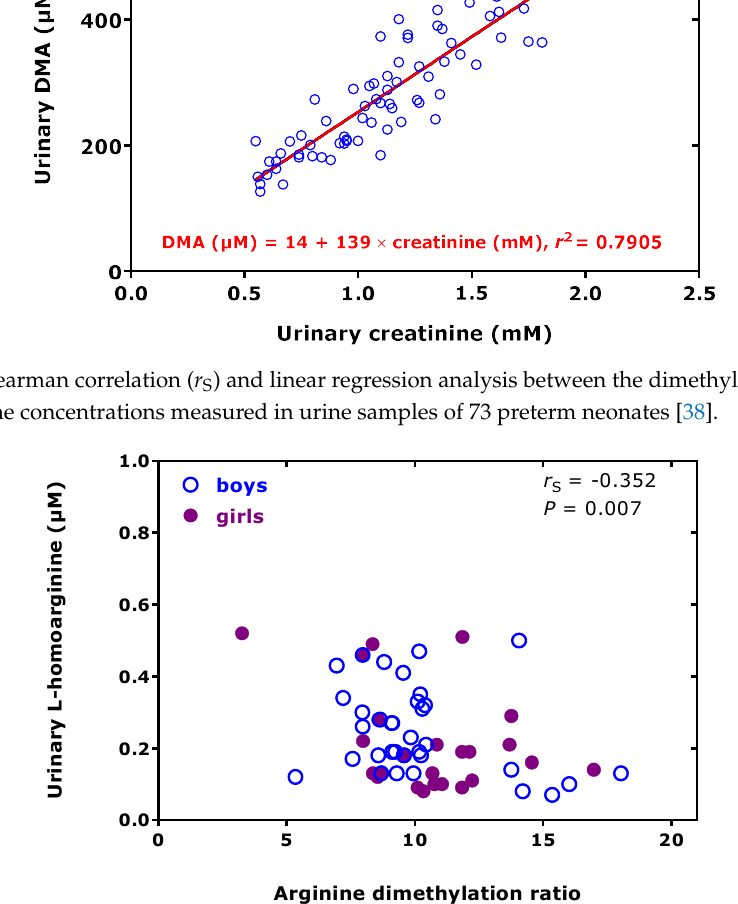
Figure 5. Spearman correlation ( r S ) between the urinary excretion of L-homoarginine and the arginine dimethylation ratio, the molar ratio of the sum of the urinary concentration of asymmetric dimethylarginine (ADMA) and dimethylamine (DMA) and of the urinary concentration of symmetric dimethylarginine (SDMA), i.e., (ADMA + DMA) / SDMA, in preterm neonates [38]. High correlations between DMA and creatinine concentrations in urine were also observed in black and white boys ( r S = 0.868, p < 0.0001; n = 79), as well as in black and white young men and women ( r S = 0.925, p < 0.0001, n = 1025). The difference between black ( n = 41) and white boys ( n = 39)